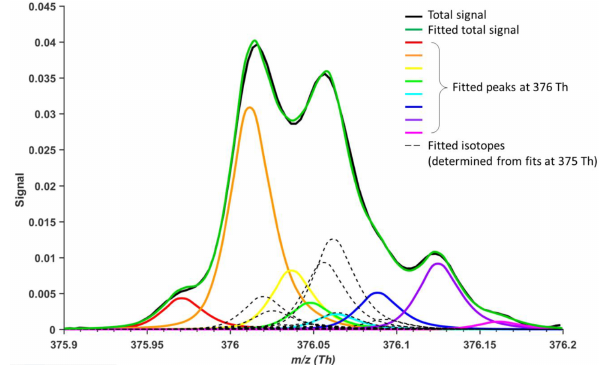
Figure 1. Example of traditional HR peak fitting. Potential peak fitting at m/z 376Th (10h average) in an atmospheric simulation chamber during a monoterpene ozonolysis experiment, utilizing a nitrate-based CI-APi-TOF (resolving power of 13000ThTh − 1 ). Even a minor shift in the mass axis calibration could cause the signals of especially the yellow, green and blue peaks to change dramatically. Similarly, adding or removing an ion would alter the amount of signal attributed to the other fitted peaks.